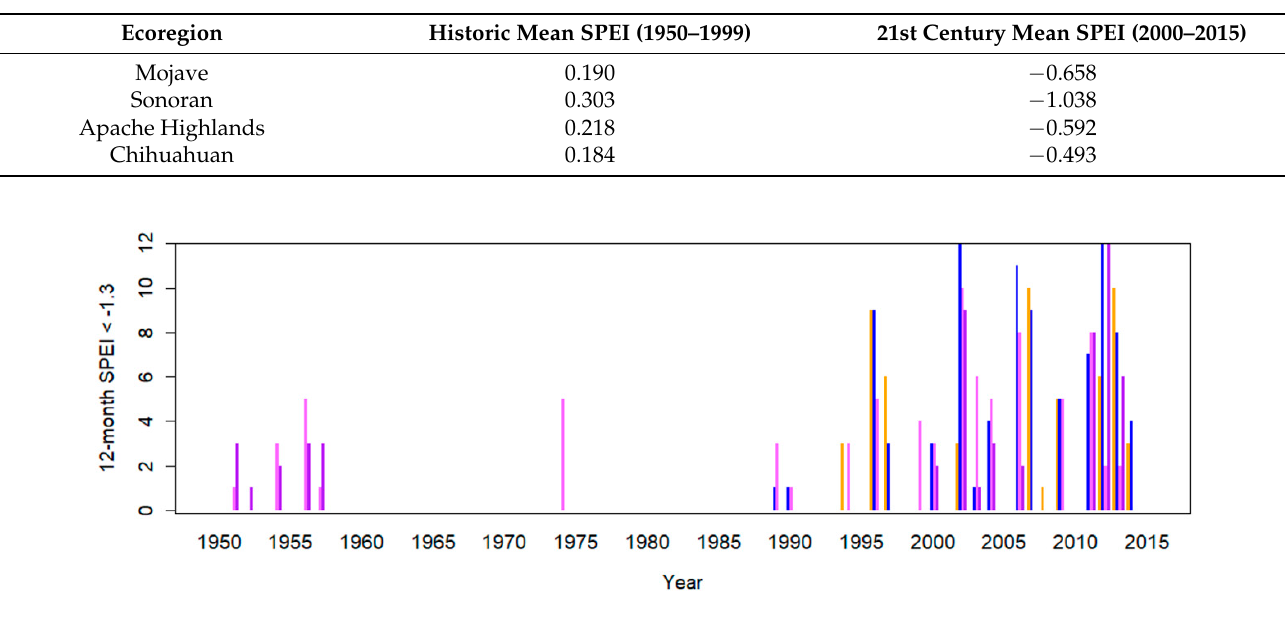
Table 2. Differences between historic mean SPEI (1950–1999) and mean SPEI of the early 21st century (2000–2015) significant at p < 0.05 using 12-month SPEI data obtained from Global Drought Monitor for all four ecoregions [31].